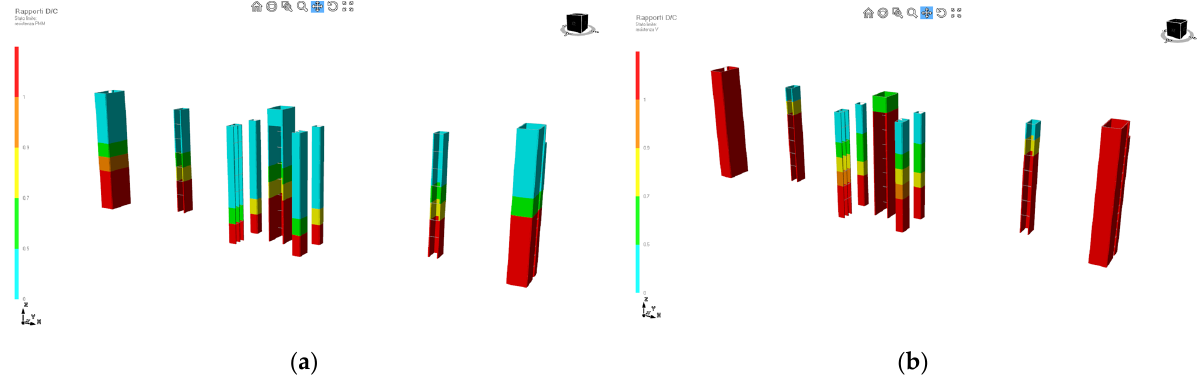
Figure 10. Demand-to-capacity ratios of the RC cores: ( a ) under bending and axial actions, ( b ) under shear actions.